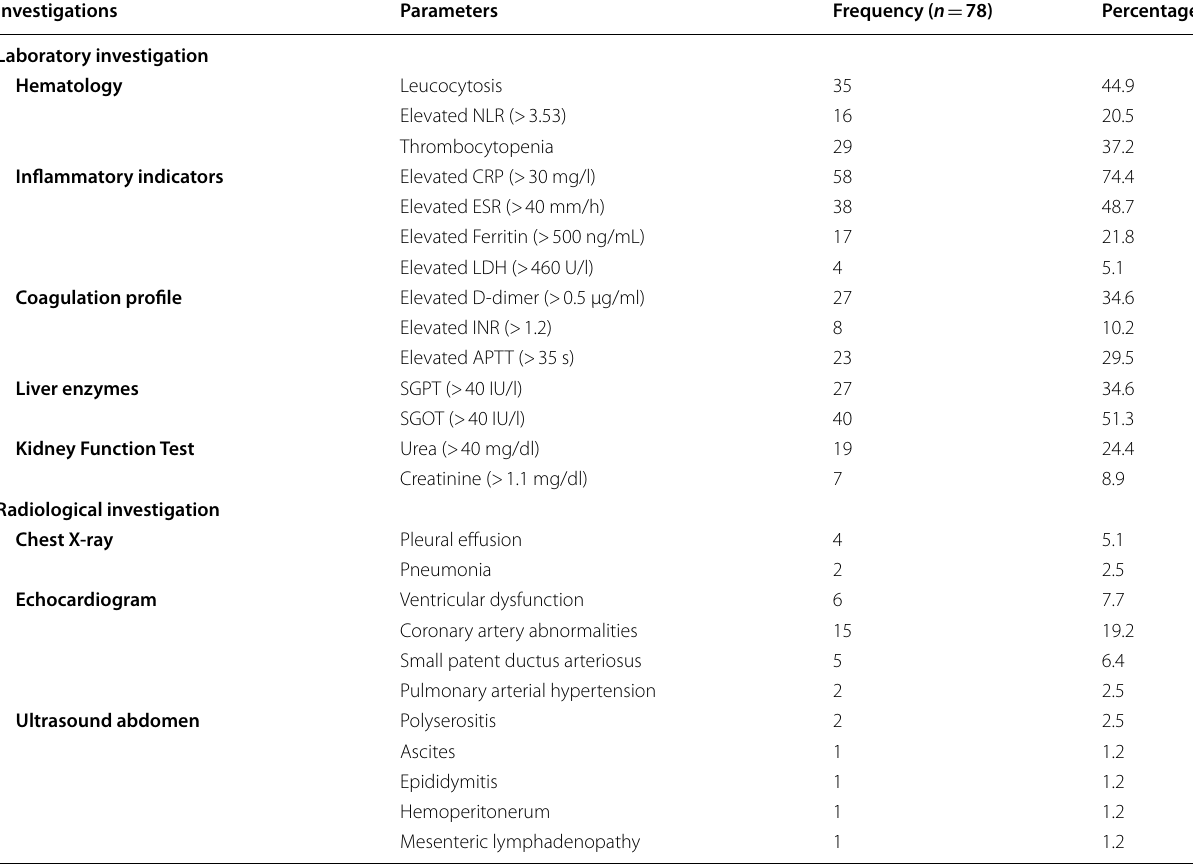
NL ratio Neutrophil–lymphocyte ratio, CRP C-reactive protein, ESR Erythrocyte sedimentation rate, LDH Lactate dehydrogenase, PT Prothrombin time, INR International normalized ratio, APTT Activated partial thromboplastin time, SGPT Serum glutamic pyruvic transaminase, SGOT Serum glutamic oxaloacetic transaminase